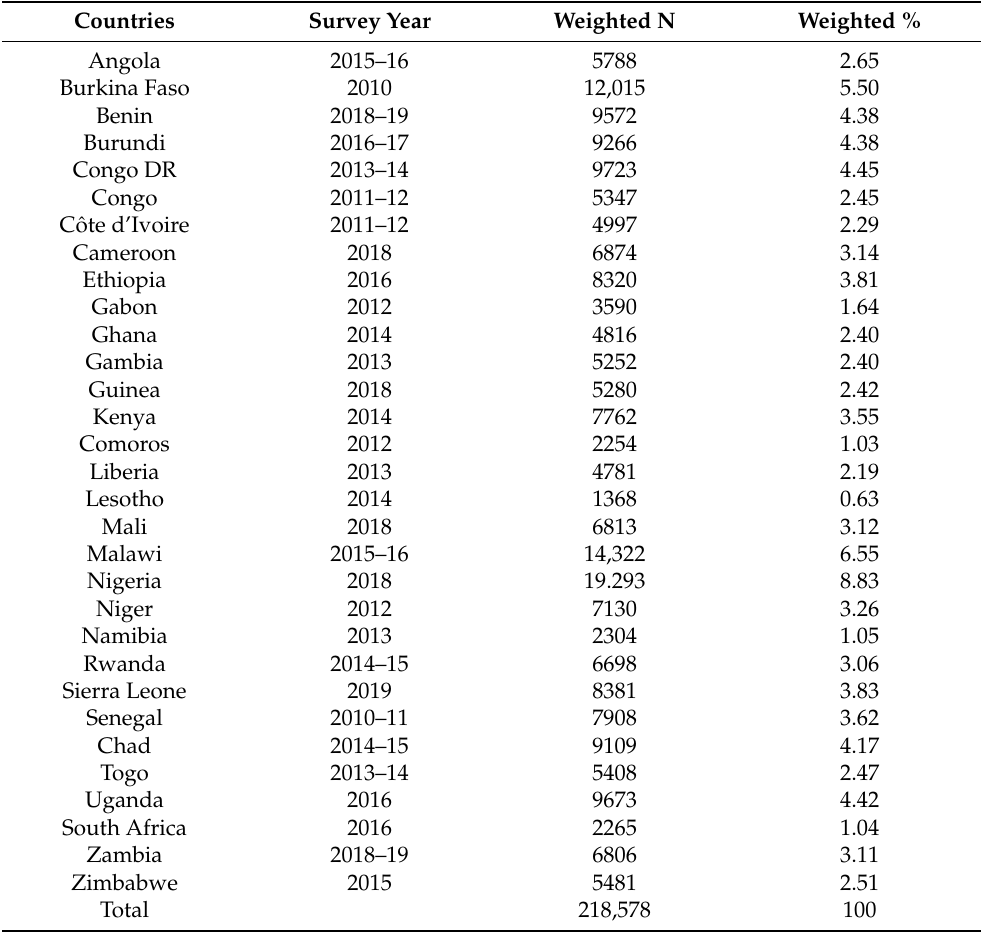
Table 1. Description of the Study